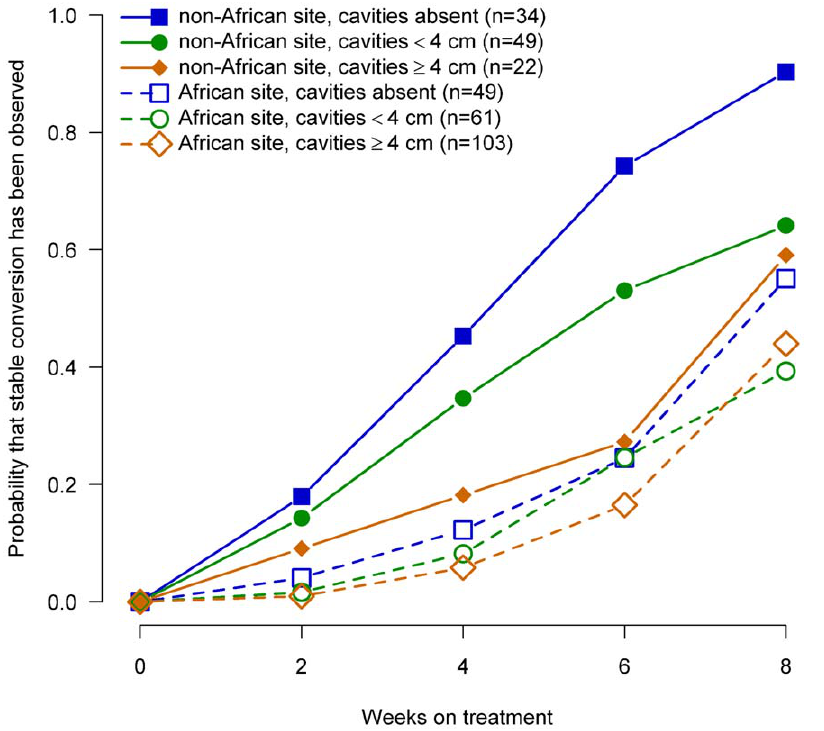
Figure 3. Probability of sputum culture conversion in liquid media by baseline aggregate cavity size, African/non-African site and week of treatment, TBTC Study 28 protocol-correct patients.